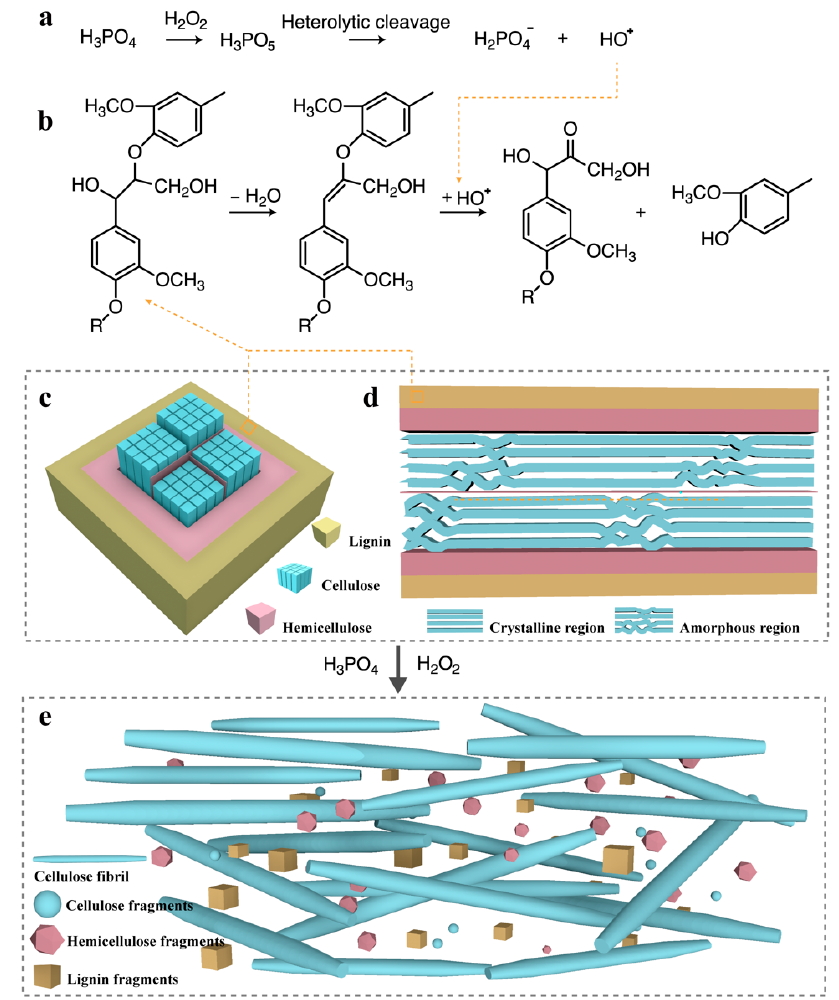
Figure 2. Schematic diagram of the microfibril structure in plant cell walls and the proposed mechanism for CNF preparation. ( a ) HO + generated; ( b ) lignin oxidatively degraded by HO + ; ( c ) cross-section of microfibrils; ( d ) longitudinal section of microfibrils; and ( e ) cellulose fibers swell and fibrillate in phosphoric acid solution.